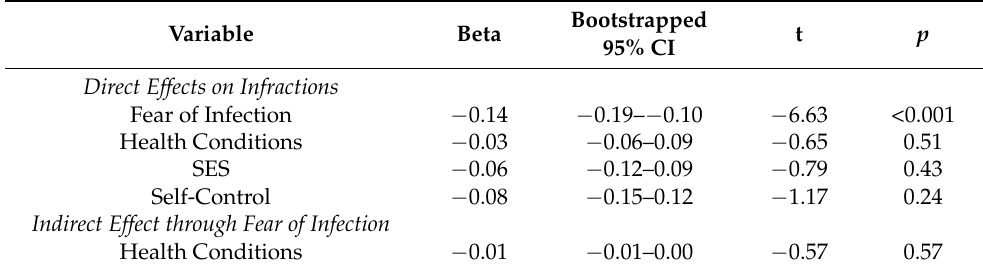
Table 2. Model 2: Direct Effects + 1 Indirect Effect.